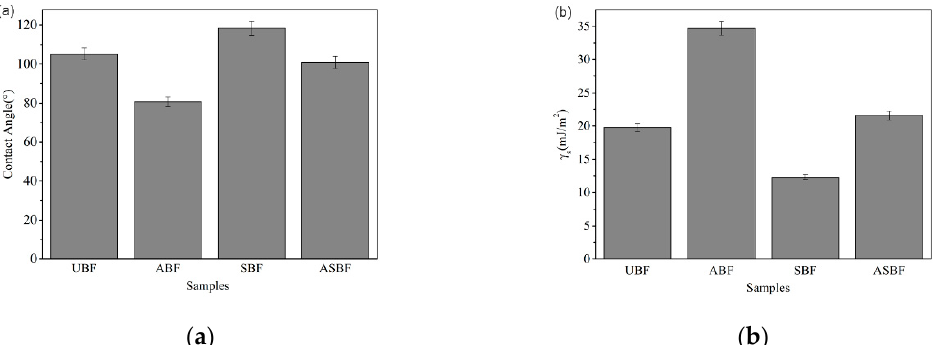
Figure 1. Surface polarity of bagasse fiber (BF) treated by different modification methods: ( a ) contact angle ( b ) surface energy.